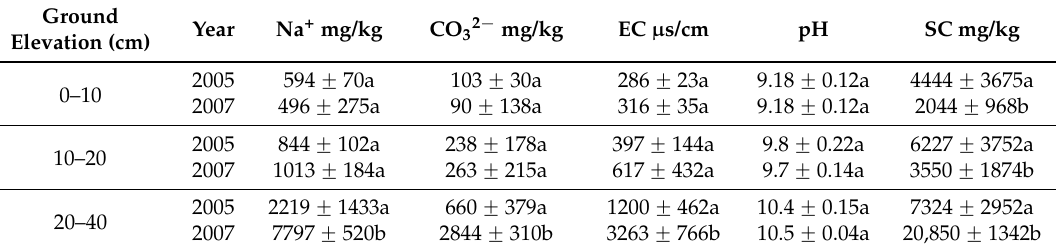
Table 2. Mean values of soil ions and index of salinity in different ground elevation.